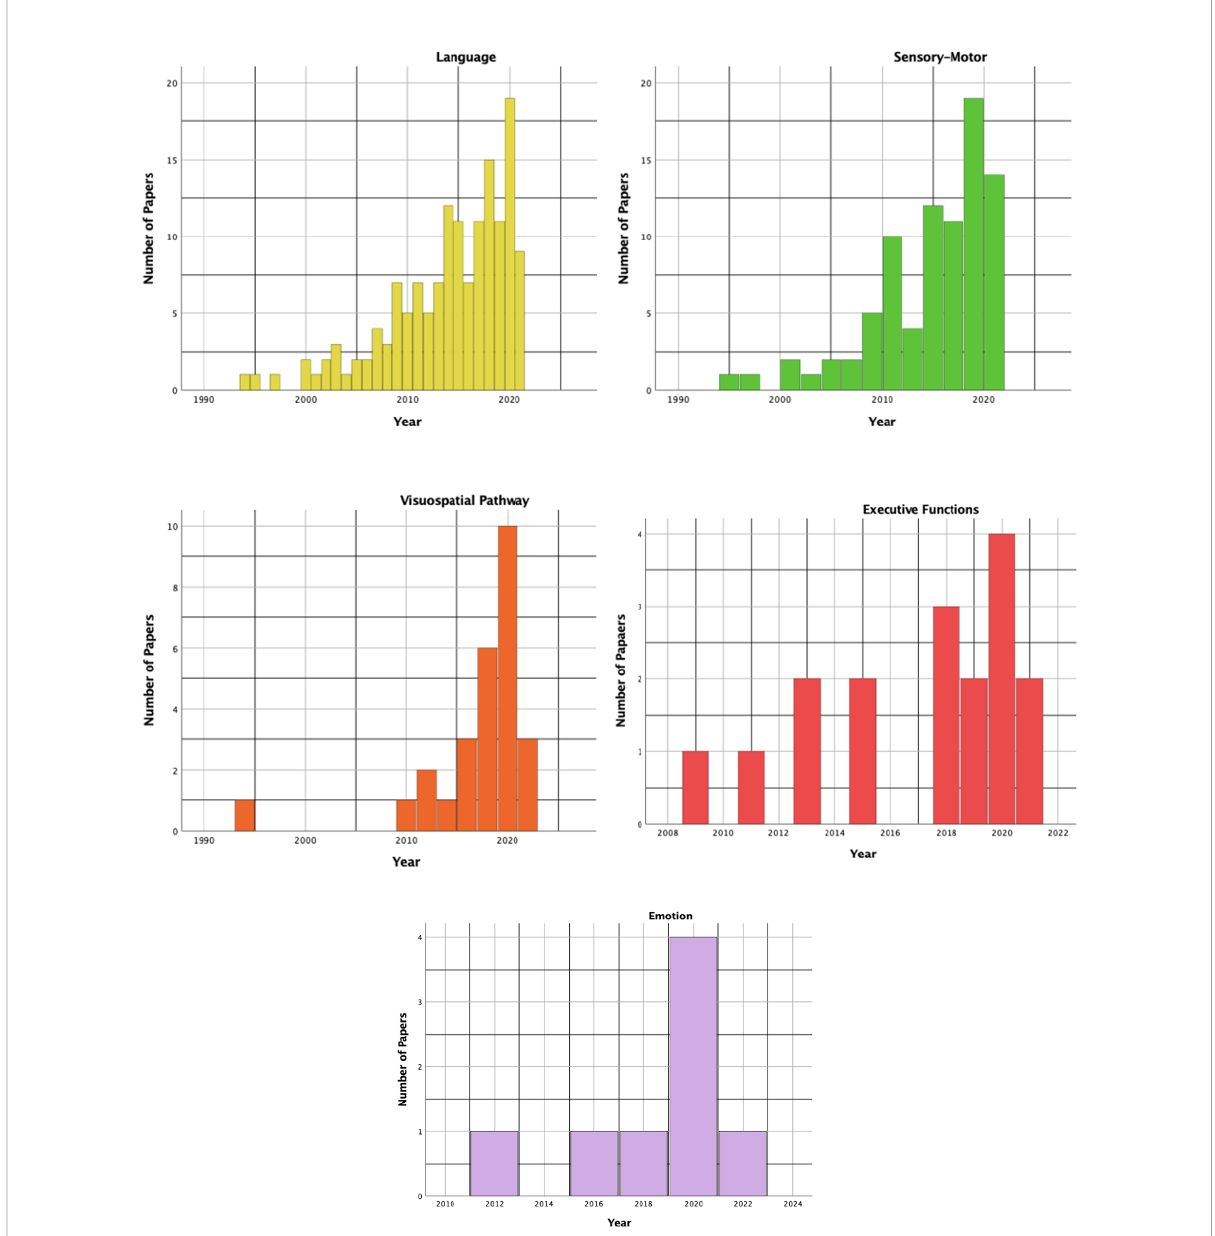
FIGURE 3 The histograms show the time distribution (by years) for each function being tested in the included